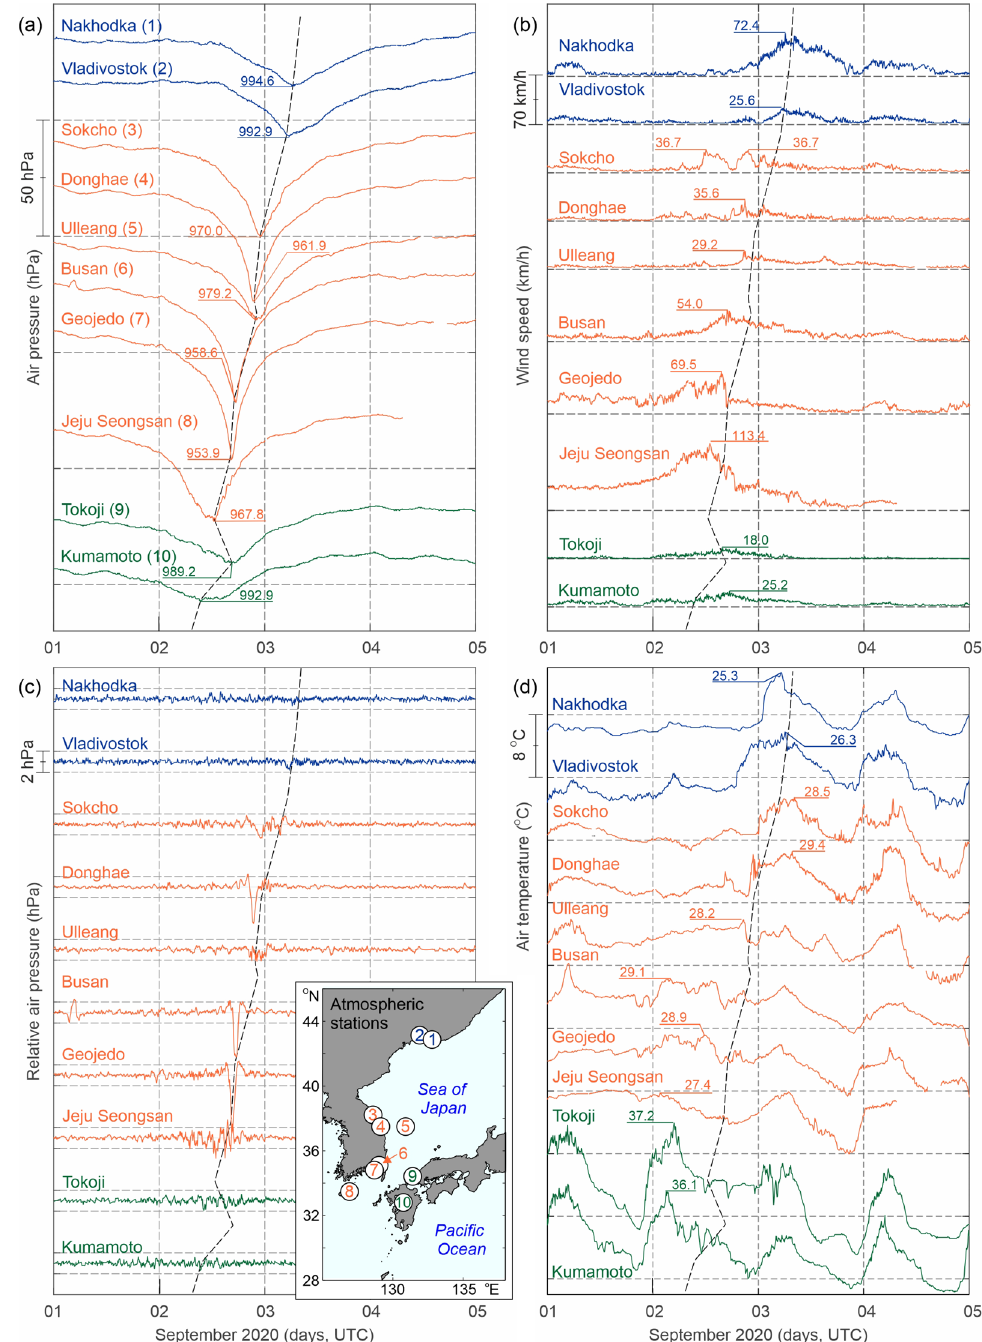
Figure 2. ( a ) Air pressure (hPa), ( b ) wind speed (km/h), ( c ) high-pass filtered air pressure (hPa) records using a 3-h Kaiser–Bessel window, and ( d ) air temperature (°C) records at ten weather stations for 1–5 September 2020. Locations of the stations (indicated by numbers 1, 2,…, 10) are shown in the inset in ( c ); the names of the weather stations are shown in plot ( a ). For all plots and the inset, records and circles in blue denote Russian stations, orange South Korean stations and green Japanese stations. Map in inset was created with MATLAB 2021. Subplots were combined and edited with CorelDraw